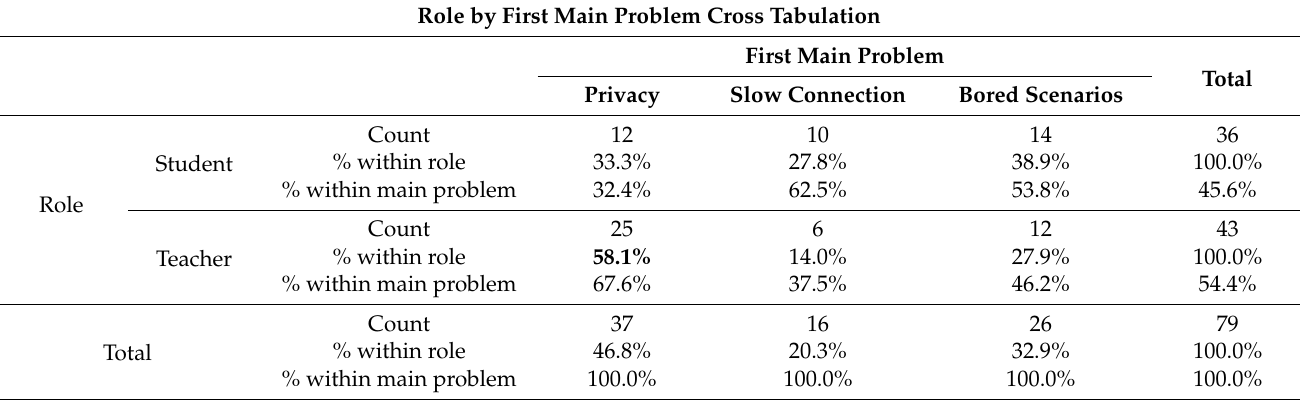
Table 4. Cross tabulation for variables role and first main problem (with percentages by row and